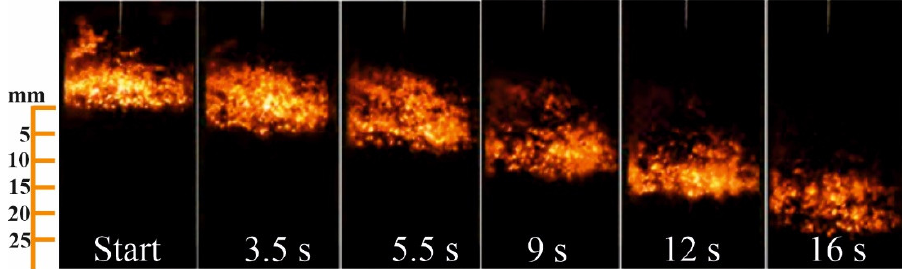
Figure 4. Combustion front propagation in the co-flow filtration mode with the parameters: 70% AlN + 30% Al, q = 3.0 cm 3 /(s∙cm 2 ), N 2 = 100%.